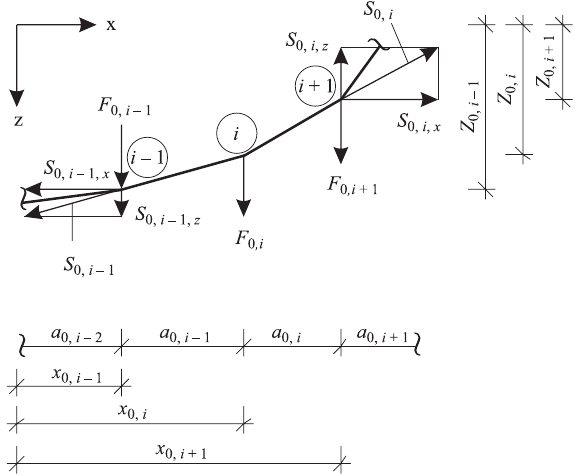
Fig. 1. Initial discrete scheme of the cable;